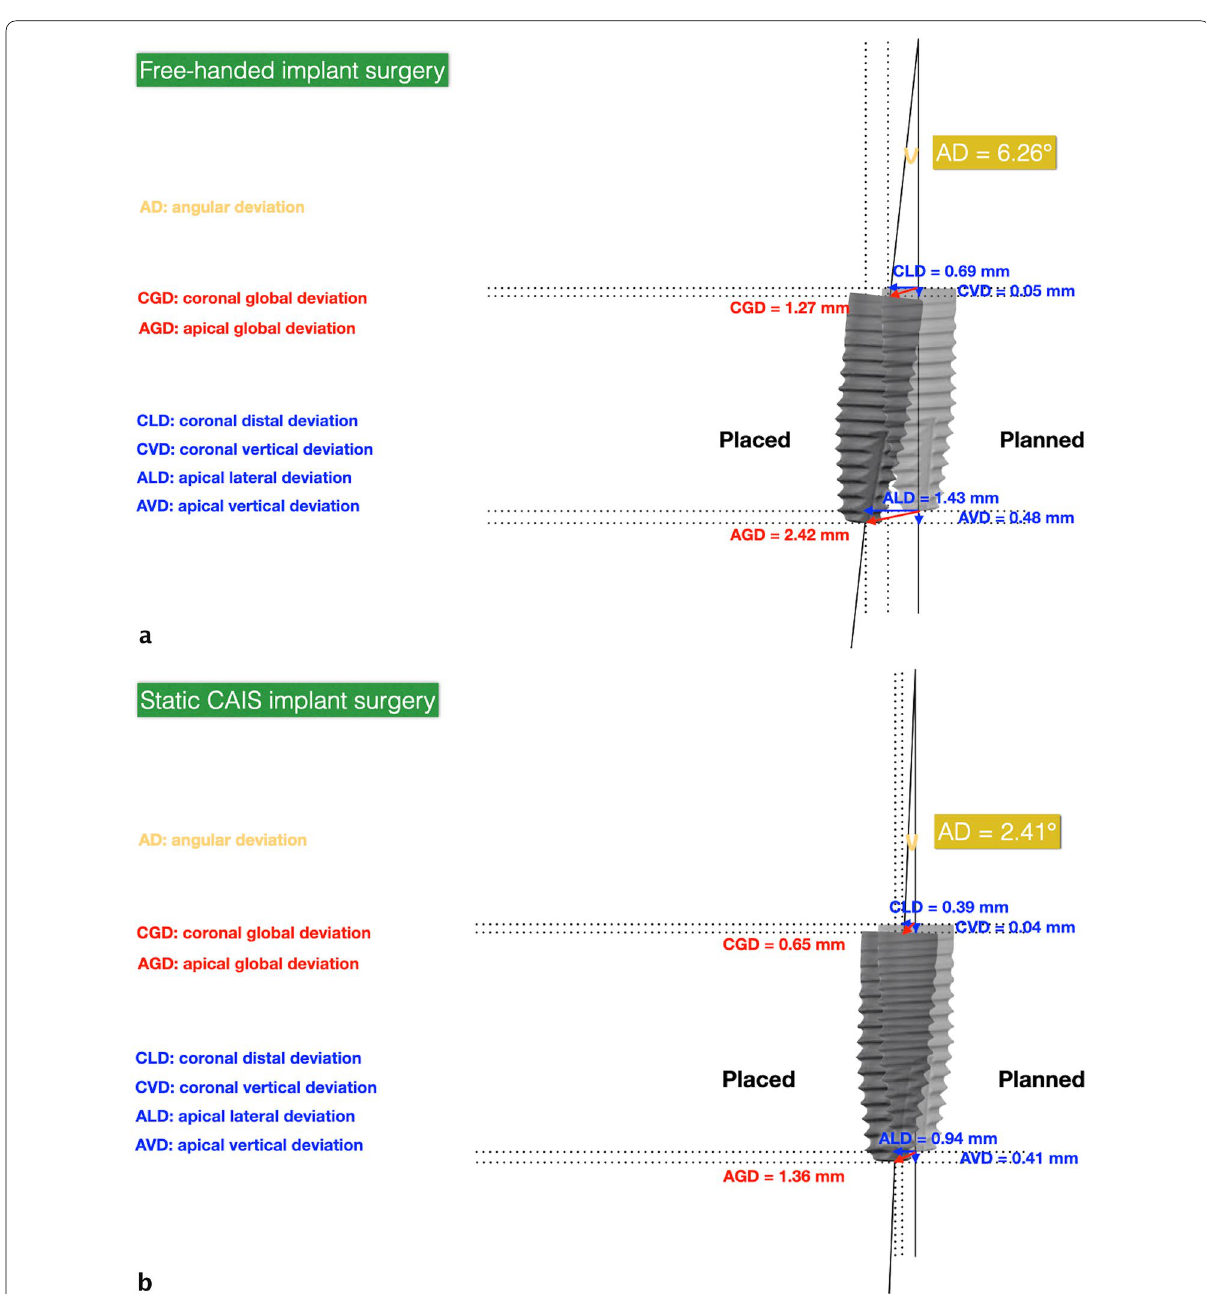
Fig. 5 Parameters of deviation between the planned implant (right) and actual implant (left) position in the free-handed ( a ) and static CAIS ( b ) implant surgery. Angular deviation (AD) is presented to scale, while the other deviations are not to scale and only serve for better visualization. The presented values are mean values taken from Table